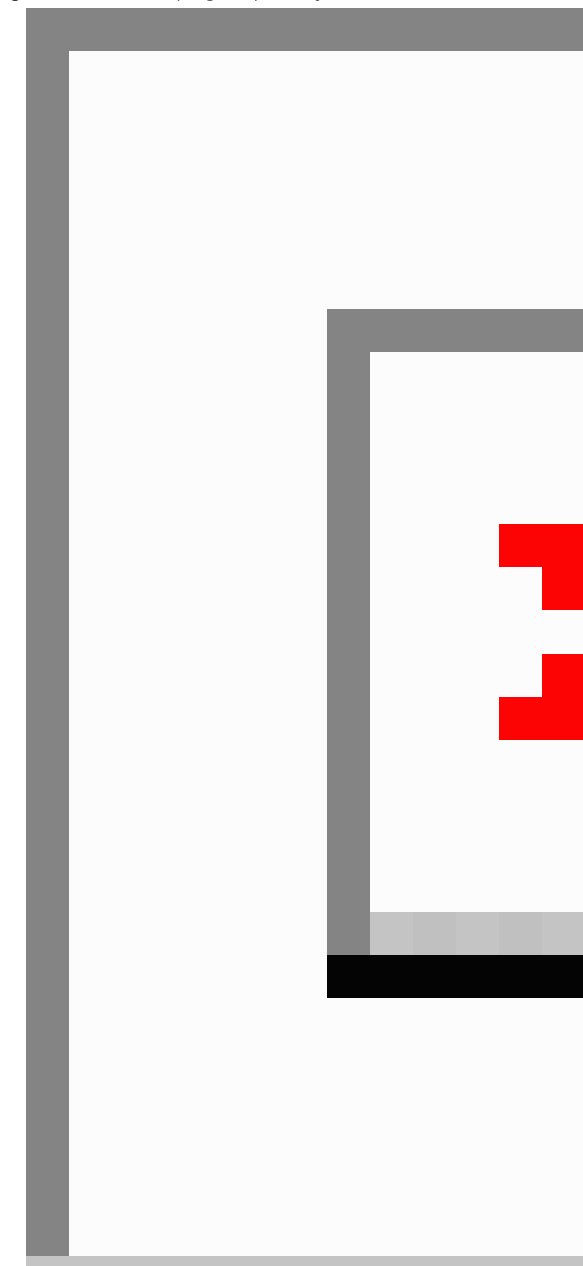
Figure 2. Telehealth program